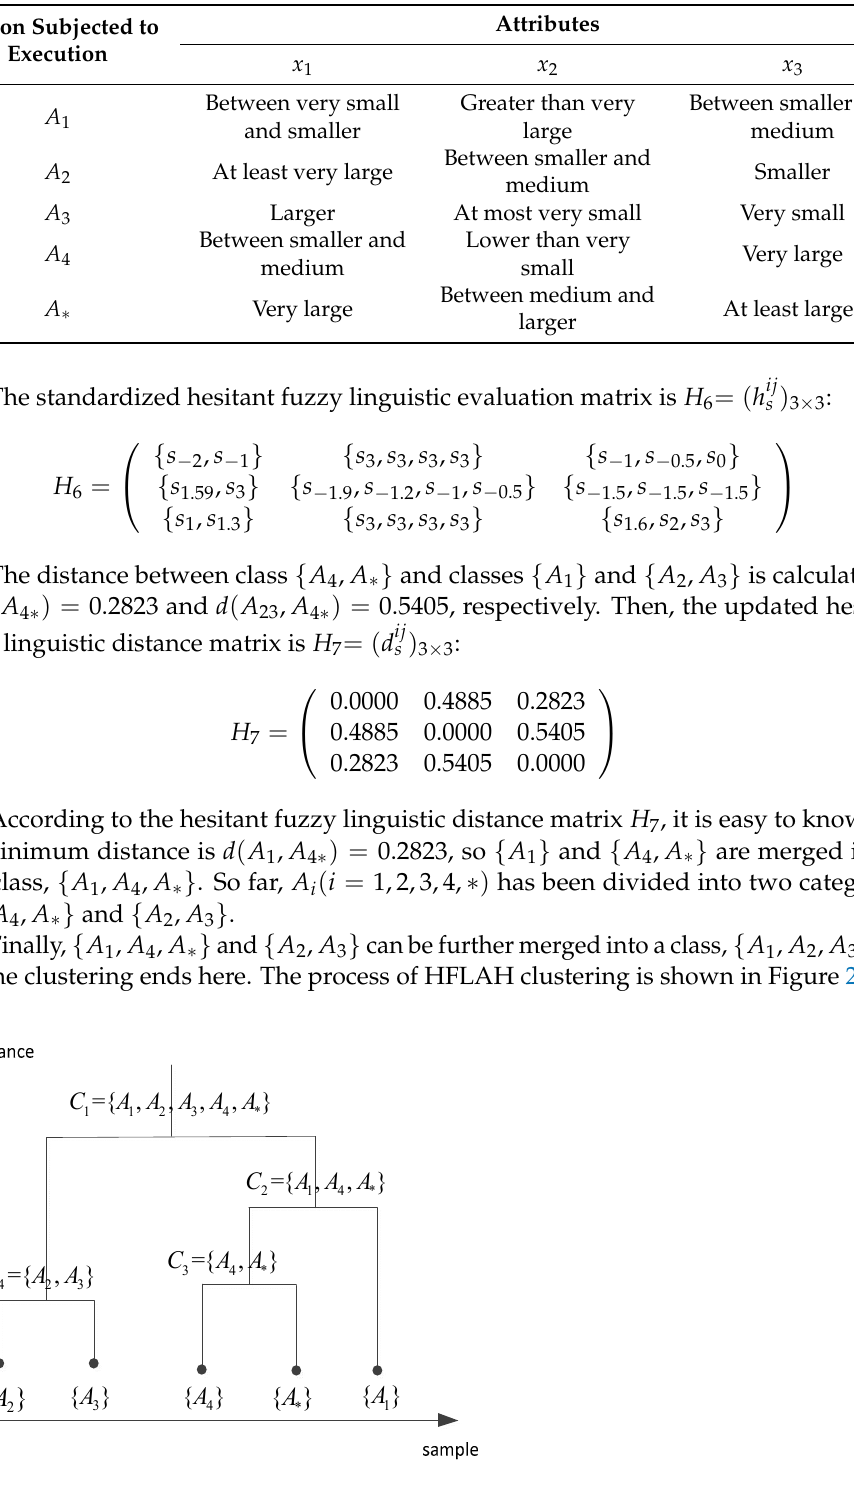
Figure 2. The clustering result of the person subjected to execution A i ( i = 1,2,3,4, ∗ )